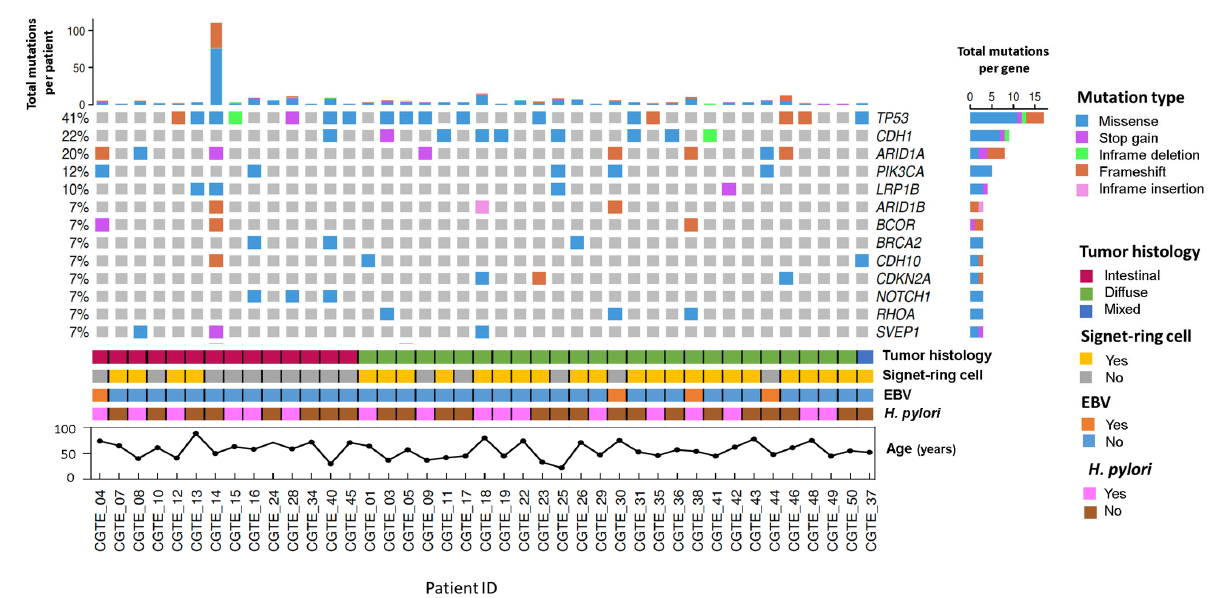
Figure 2. Driver somatic variants and clinical characteristics of patients with gastric adenocarcinoma treated at The Instituto Nacional de Cancerología between January 2019 and January 2020 (n = 41). treated at The Instituto Nacional de Cancerolog í a between January 2019 and January 2020 (n = 41). Oncoprint, sorted by tumor histology, depicting the genes affected by driver somatic variants (single nucleotide variations, small insertions, and small deletions) in 7% or more of the samples. Less frequent driver somatic variants can be found in Supplementary Table S1. The variants are represented according to the mutation type, each described on the right color panel. The upper bar plot represents the number of driver somatic variants per patient, and the right bar plot represents the number